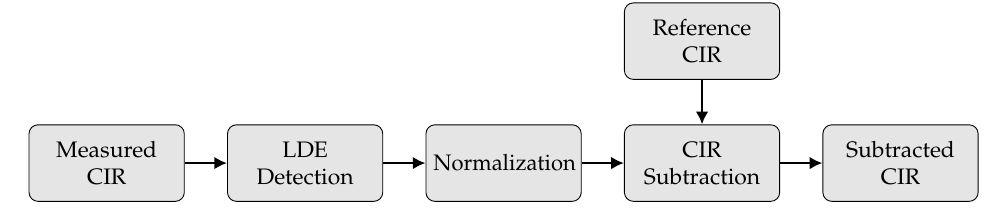
Figure 5. Detailed computation steps of CIR